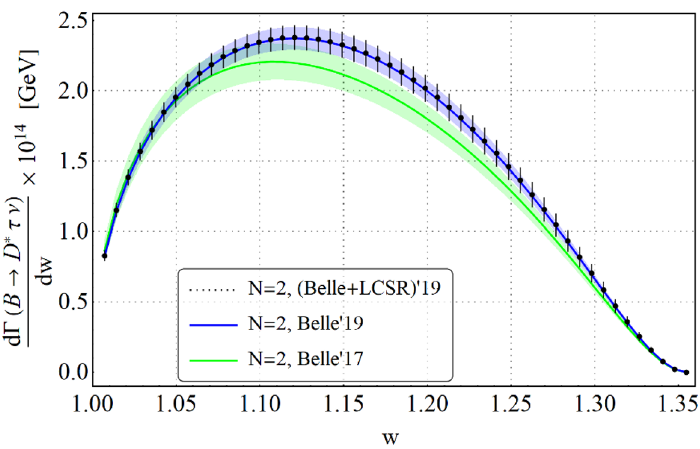
Figure 3. Comparison between B ! D (cid:3) (cid:28)(cid:23) (cid:28) decay distributions obtained from di(cid:11)erent (cid:12)t scenar- ios discussed in table 6. This plot uses the same colour-coding as the form-factor plots in (cid:12)gure